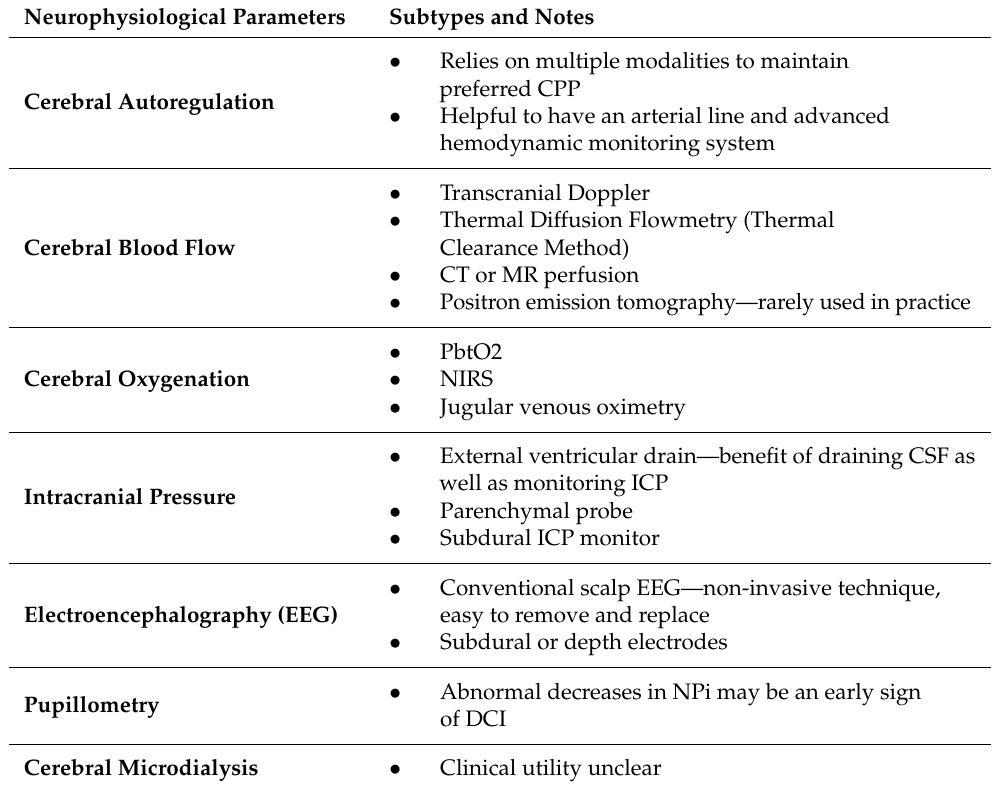
Table 2. Multimodal Advanced Neuromonitoring.